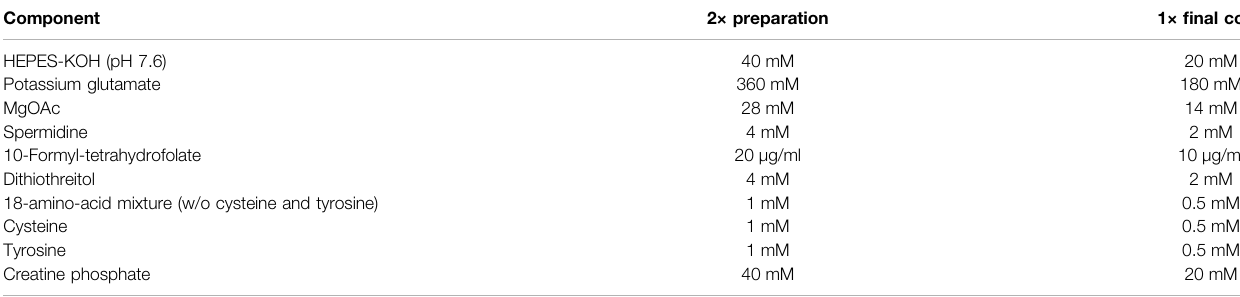
TABLE 3 | Example of the outer solution of arti fi cial cell encapsulating the PURE system. Component 2× preparation 1× fi nal conc HEPES-KOH (pH